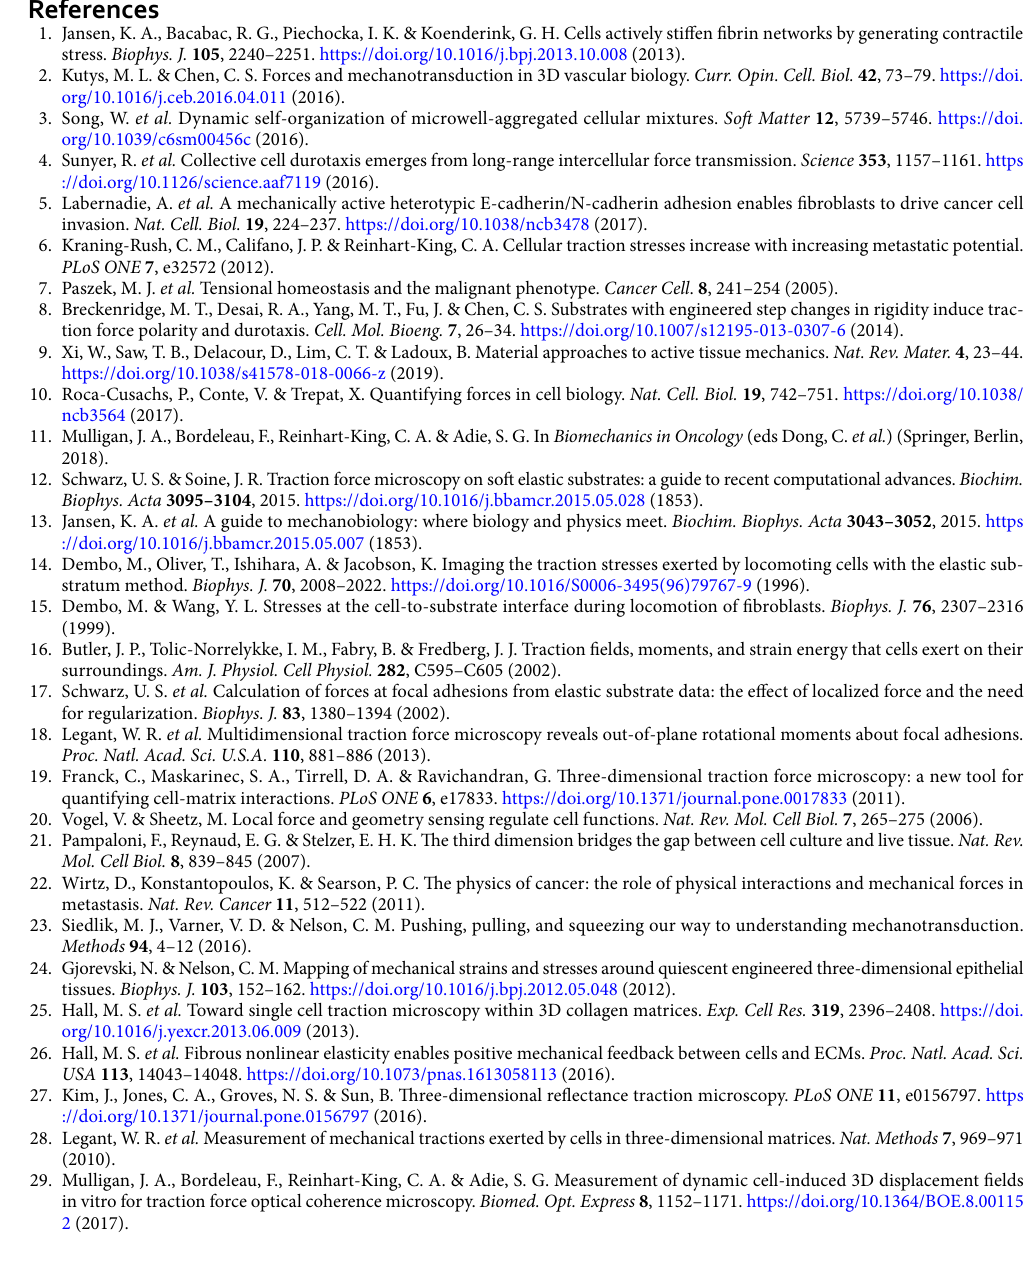
Figure/video generation. All figure/video panels were generated/rendered using MATLAB R2019b. Fig- ures were arranged using Microsoft PowerPoint 2016. Data availability Code